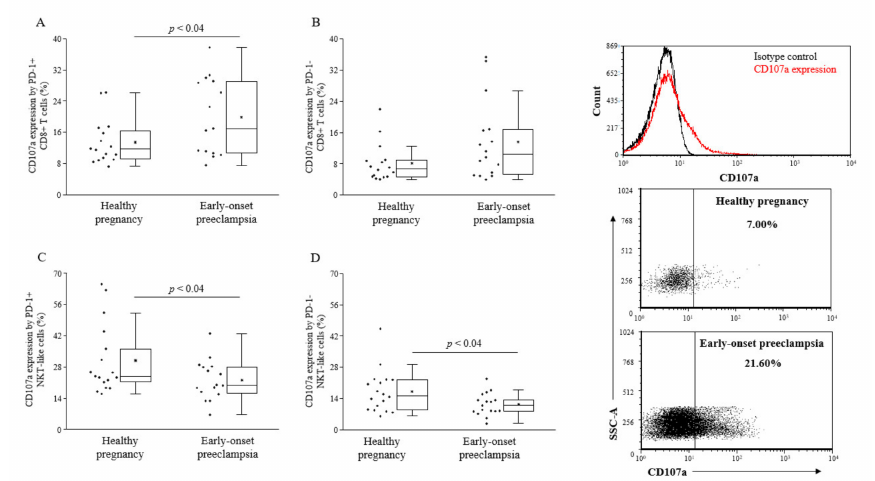
Figure 3. Cytotoxicity of peripheral CD8+ T cells and NKT-like cells in 3rd-trimester healthy pregnant women and in women with early-onset preeclampsia. The expression of CD107a by PD-1 positive and negative CD8+ T cells ( A and B ) and NKT-like cells ( C and D ) in peripheral blood of women with early-onset preeclampsia and in healthy pregnant women. The solid bars represent medians of 17 and 17 determinations, respectively, the boxes indicate the interquartile ranges, and the lines show the most extreme observations. Differences were considered statistically significant for p -values ≤